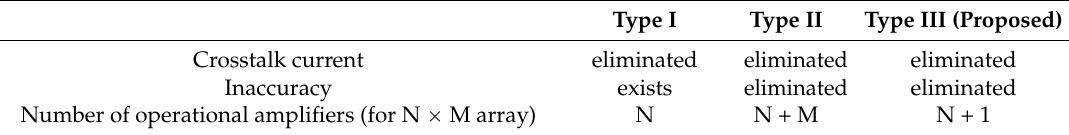
Table 1. Comparison of three types of row